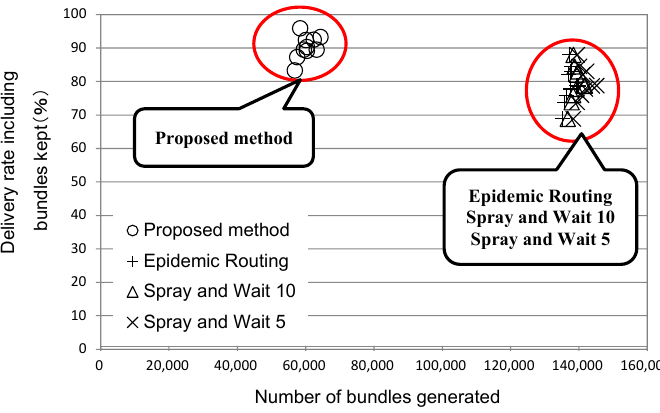
Figure 13. Battery consumption rate of victim terminals and the storage usage of carrier terminals in each method.